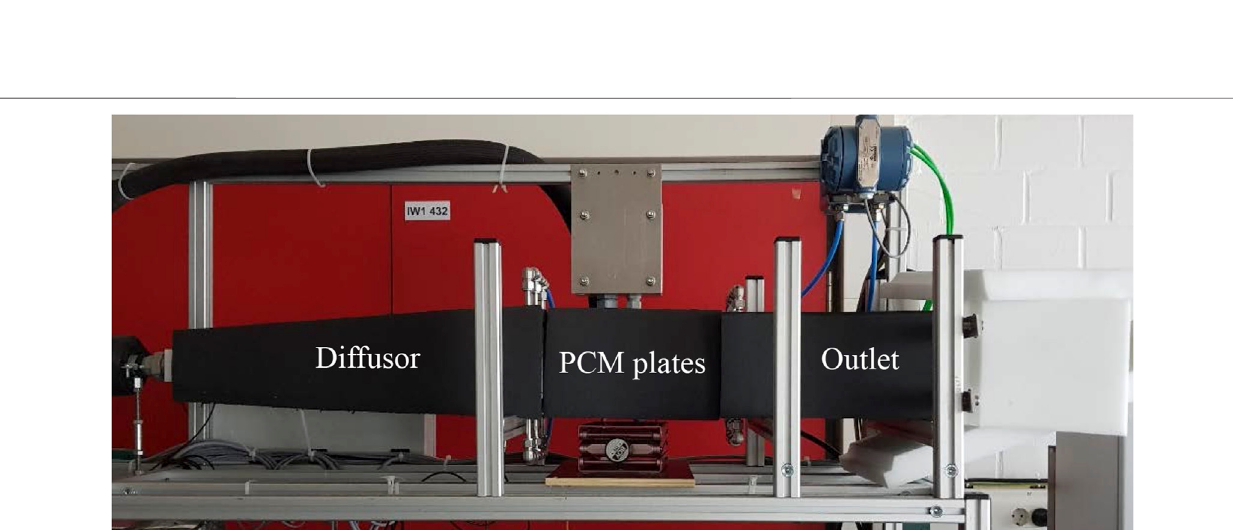
Frontiers in Energy Research |